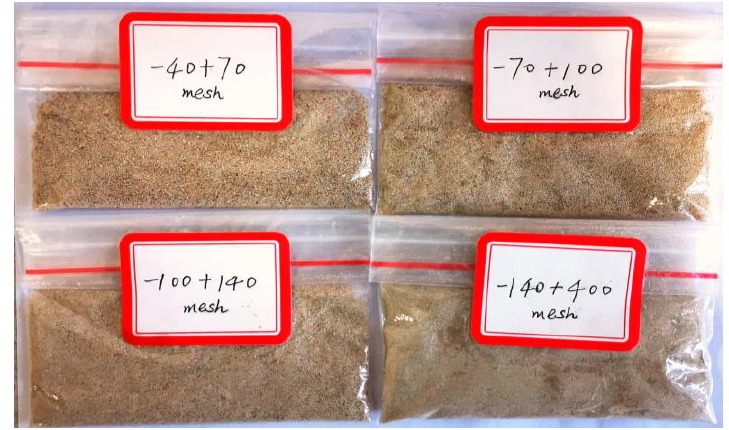
Figure A1. Quartz-sand picture of four Figure A1. Quartz - sand picture of four fractions.